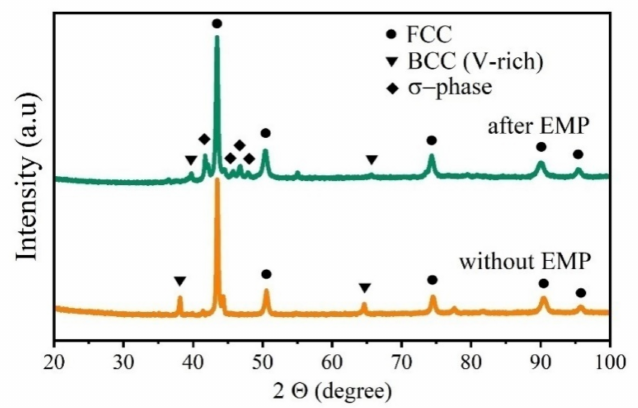
Figure 5. X-ray spectra of Al 0.25 CoCrFeNiV HEA before and after EMP treatment. According to our XRD analysis, the σ -phase is characterized by a tetragonal crystal lattice with parameters a = 8.816 Ǻ and c = 4.571 Ǻ , which coincides with the results re- ported by Salishchev et al. [28], where the σ -phase is characterized by a tetragonal lattice with parameters that can vary between a = 8.794–8.826 Ǻ and c = 4.566–4.578 Ǻ (de- pending on the degree of lattice distortion). Moreover, considering the interaction vol- ume of electrons with the sample in EDS analysis (which is about 1 μ m [44]), the precise chemical composition of the σ precipitates could not be determined.